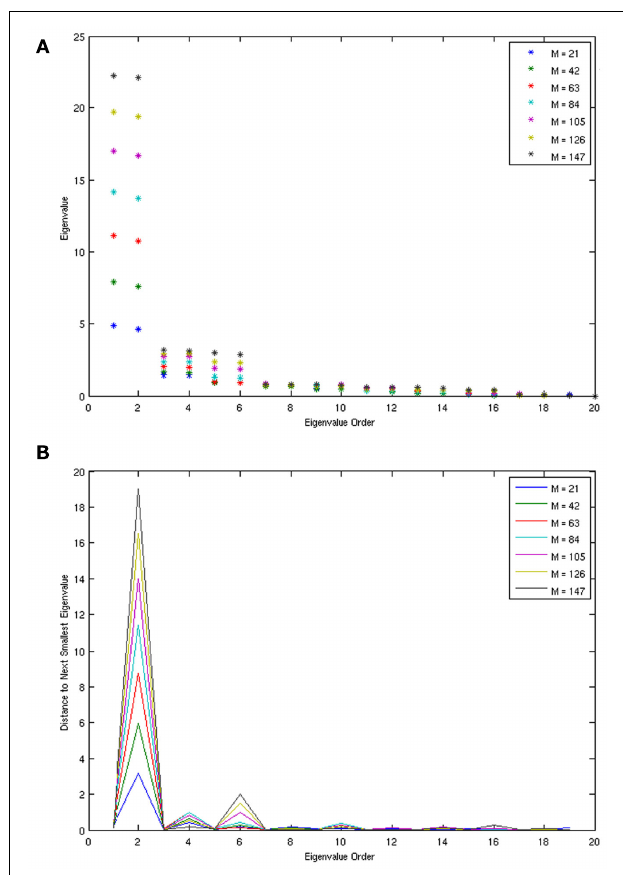
FIGURE 4 |The eigenvalues (A) and eigenvalue spacing (B) identified by SSA for the Lorenz system at varying window sizes. Eigenvalues are correctly identified in three pairs, each pair representing a single variable from the system.The three pairs clearly rise above the zero